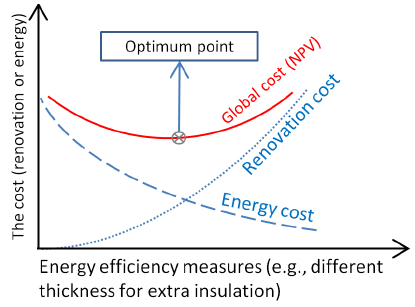
Figure 5. NPV of global cost concept for energy efficiency measures.